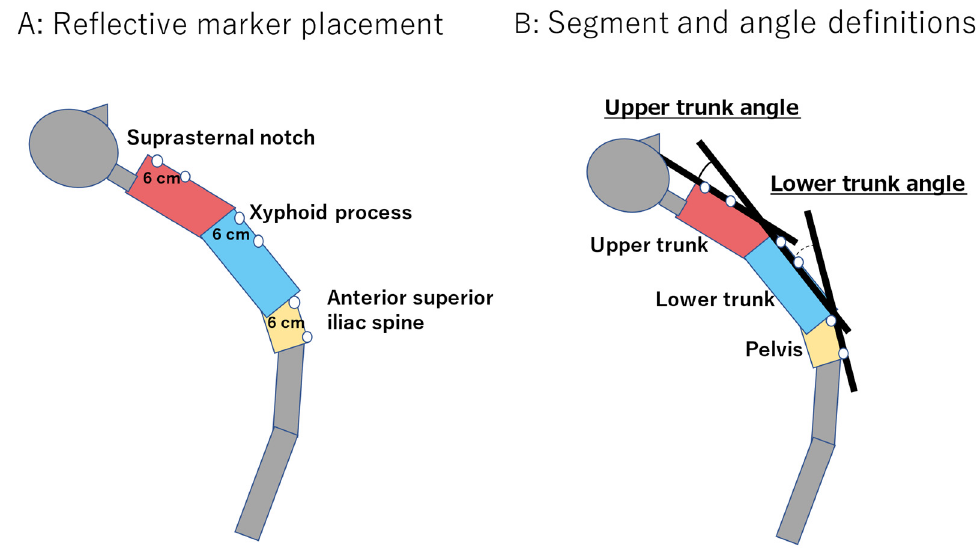
Figure 2. ( A ) Marker positioning for trunk extension angle measurements; ( B ) Definitions of angles and segments.